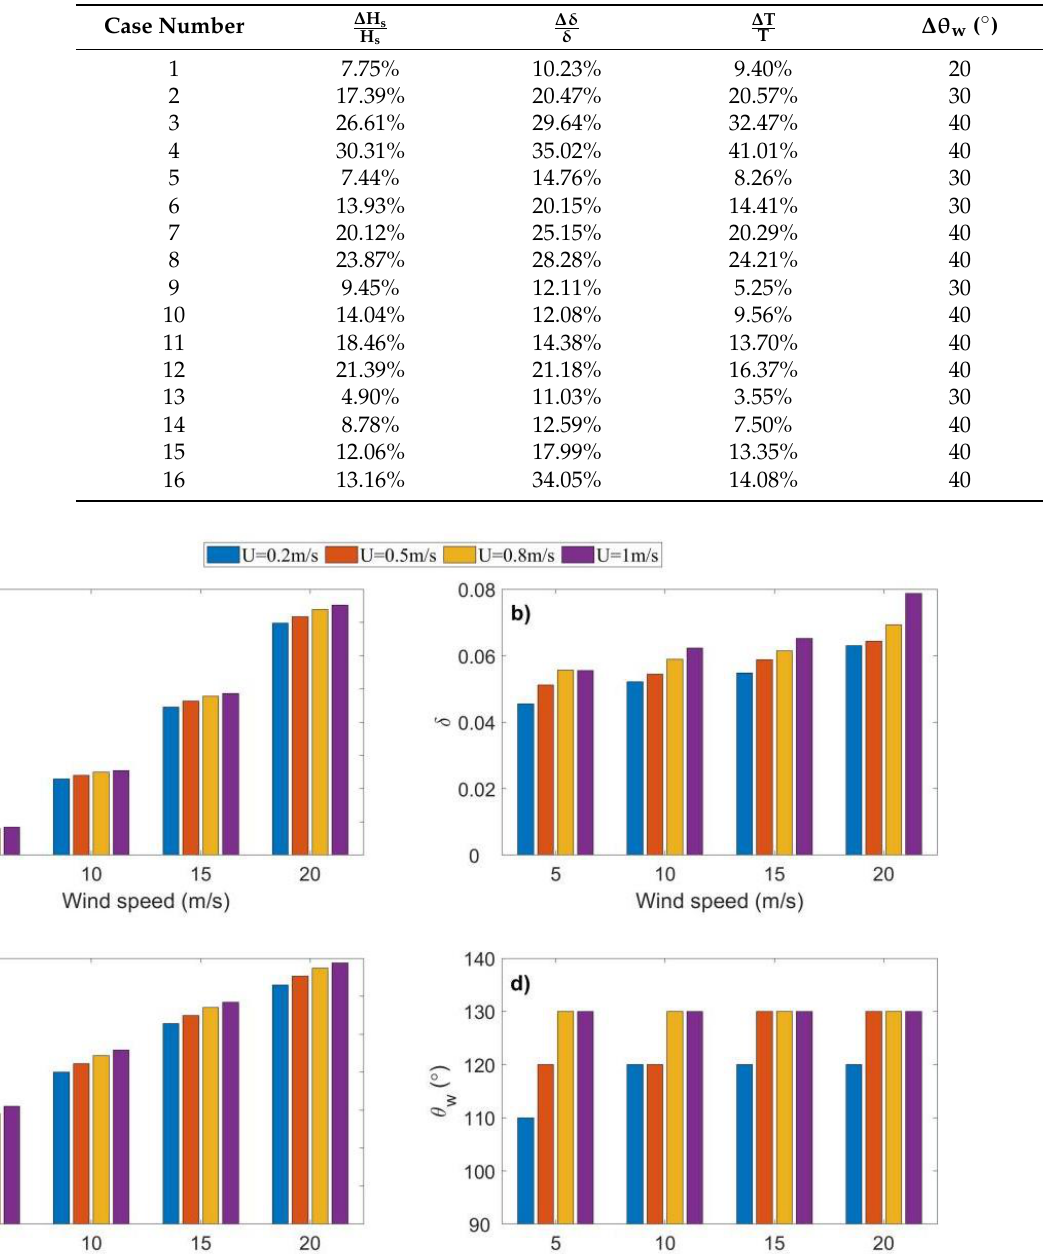
Table 3. Variations of wave parameters at different cases.